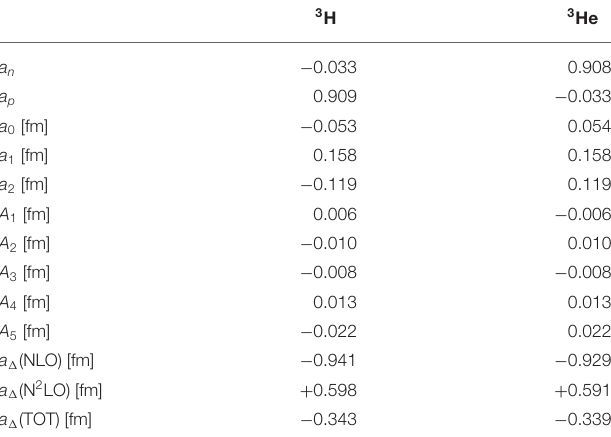
TABLE 11 | The same as in Table 10 but for the 3 H and 3 He